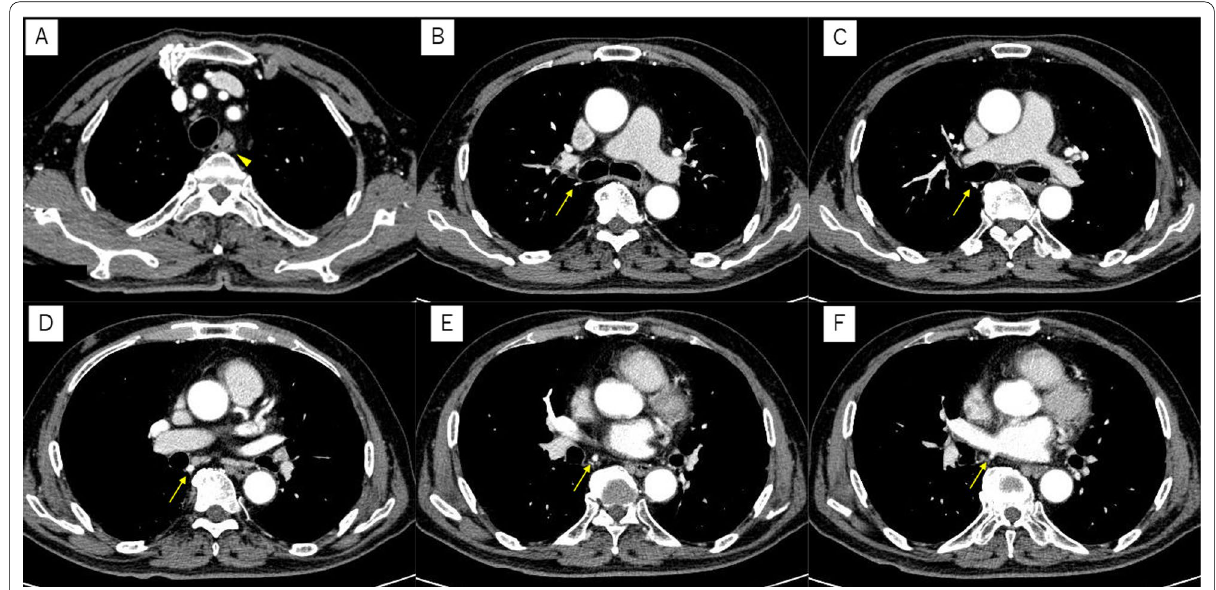
Fig. 1 Contrast-enhanced CT findings. A Contrast-enhanced CT showed mural thickening of the anterior wall of the upper thoracic esophagus, with no evidence of multi-organ invasion or lymph node metastasis. B – F A break in the right pulmonary vein passing dorsal to the right main bronchus and flowing directly into the left atrium was observed (arrow in the